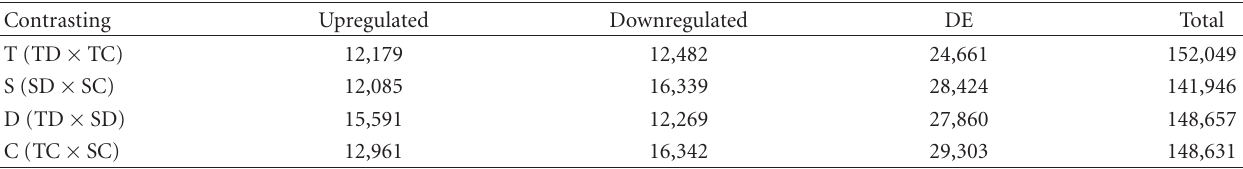
Table 1: Total number of di ff erentially expressed (DE; P ≤ 0 . 05) up- or downregulated tags observed in di ff erent contrasting